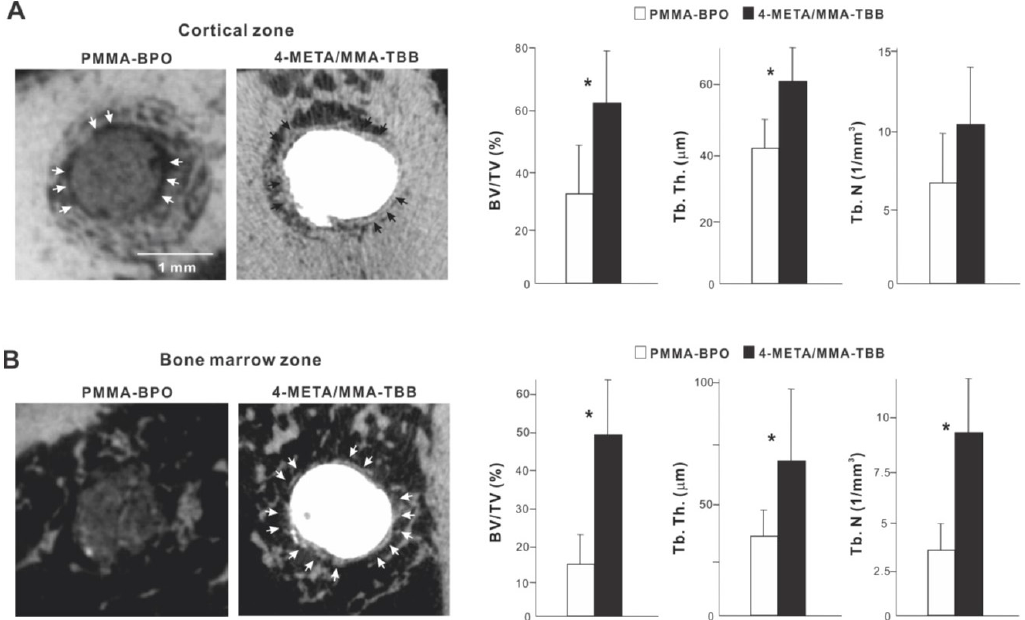
Figure 8. Peri-cement osteogenic behavior around two different materials evaluated by microCT at week 2 of healing. Representative cross-sectional CT images along the long axis of the implant: ( A ) a slice 0.3 mm from the implant top, and ( B ) the bone marrow cavity, a slice 0.3 mm from the implant apex. The quantitative evaluation of bone volume/tissue volume (BV/TV), trabecular thickness (Tb. Th), and trabeculae number (Th. N) are shown for each zone. * p < 0.05, statistically significant difference between the two materials.